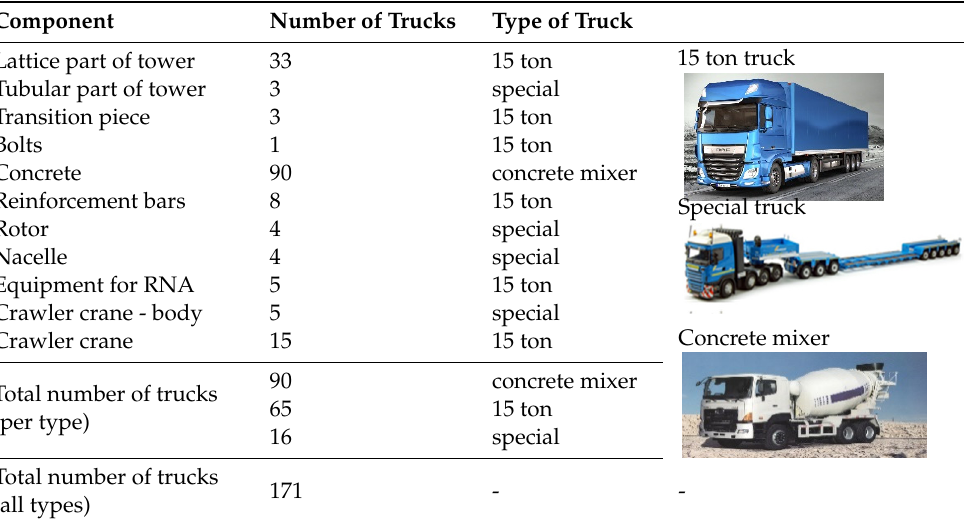
Table 3. Estimated number of trucks for 20 year life cycle.